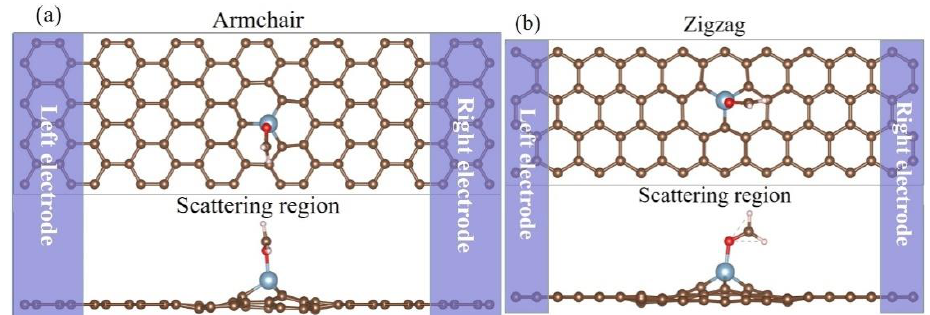
Figure 5. Top and side views of two-probe AlG nano-sensor for HCHO molecule detection along ( a ) armchair and ( b ) zigzag directions. The purple shadow regions represent the semi-infinite intrinsic left and right graphene electrodes, which are contacted with the central AlG substrate adsorbed by HCOH in the molecule scattering.